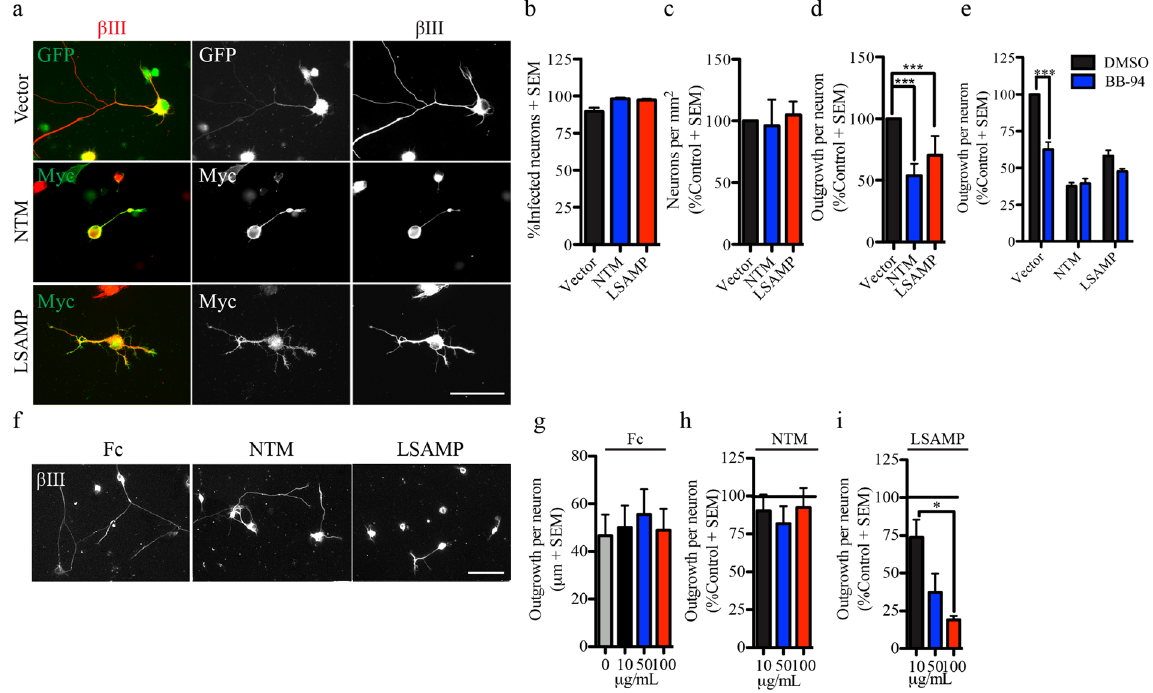
Figure 5. Ectopic surface NTM and LSAMP repress neurite outgrowth in embryonic DRG neurons. ( a ) Embryonic (E18-19) DRG neurons seeded on a PLL substrate and expressing HSV-GFP or HSV-Myc-tagged IgLON constructs. Surface Myc-IgLON expression was detected with anti-Myc antibody in the absence of permeabilization. ( b – e ) Quantification of the number of infected neurons ( b ), total number of seeded neurons ( c ) and neurite outgrowth ( d , e ) from E18-19 DRG neurons expressing GFP (vector) or Myc-IgLON proteins in the presence or absence of BB-94. Data were normalized to control HSV-GFP. N = 3–6 from independent cultures. ( f ). β III tubulin stained E18-19 DRG neurons plated on immobilized Fc or FC-IgLON substrates. ( g – i ) Quantification of outgrowth from embryonic DRG neurons seeded on immobilized Fc-IgLON substrates (10, 50 and 100 μ g/mL). Data were normalized to control Fc substrate. N = 4 from independent cultures. Data are shown as mean + S.E.M. * p < 0.05, ** p < 0.01, *** P < 0.001 by one-way ANOVA followed by Bonferroni post hoc test. Scale bar, 50 μ